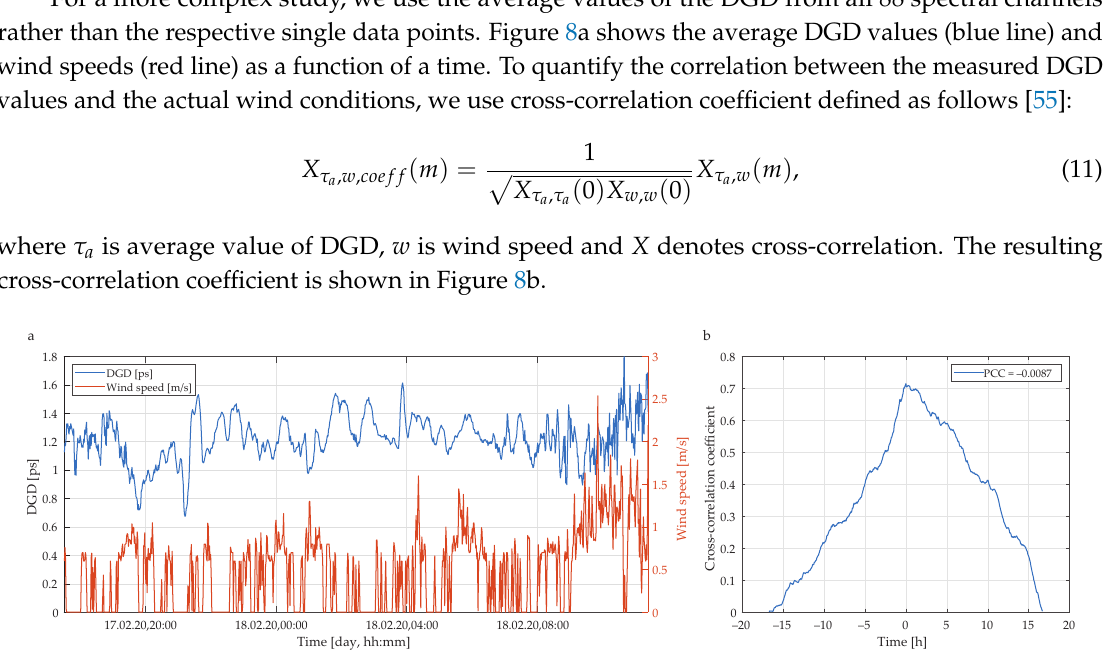
Figure 8. ( a ) Measured changes in average DGD and wind speed versus the measurement time. ( b ) Cross-correlation between measured DGD values and PCC. Weak wind condition (wind speed up to 5